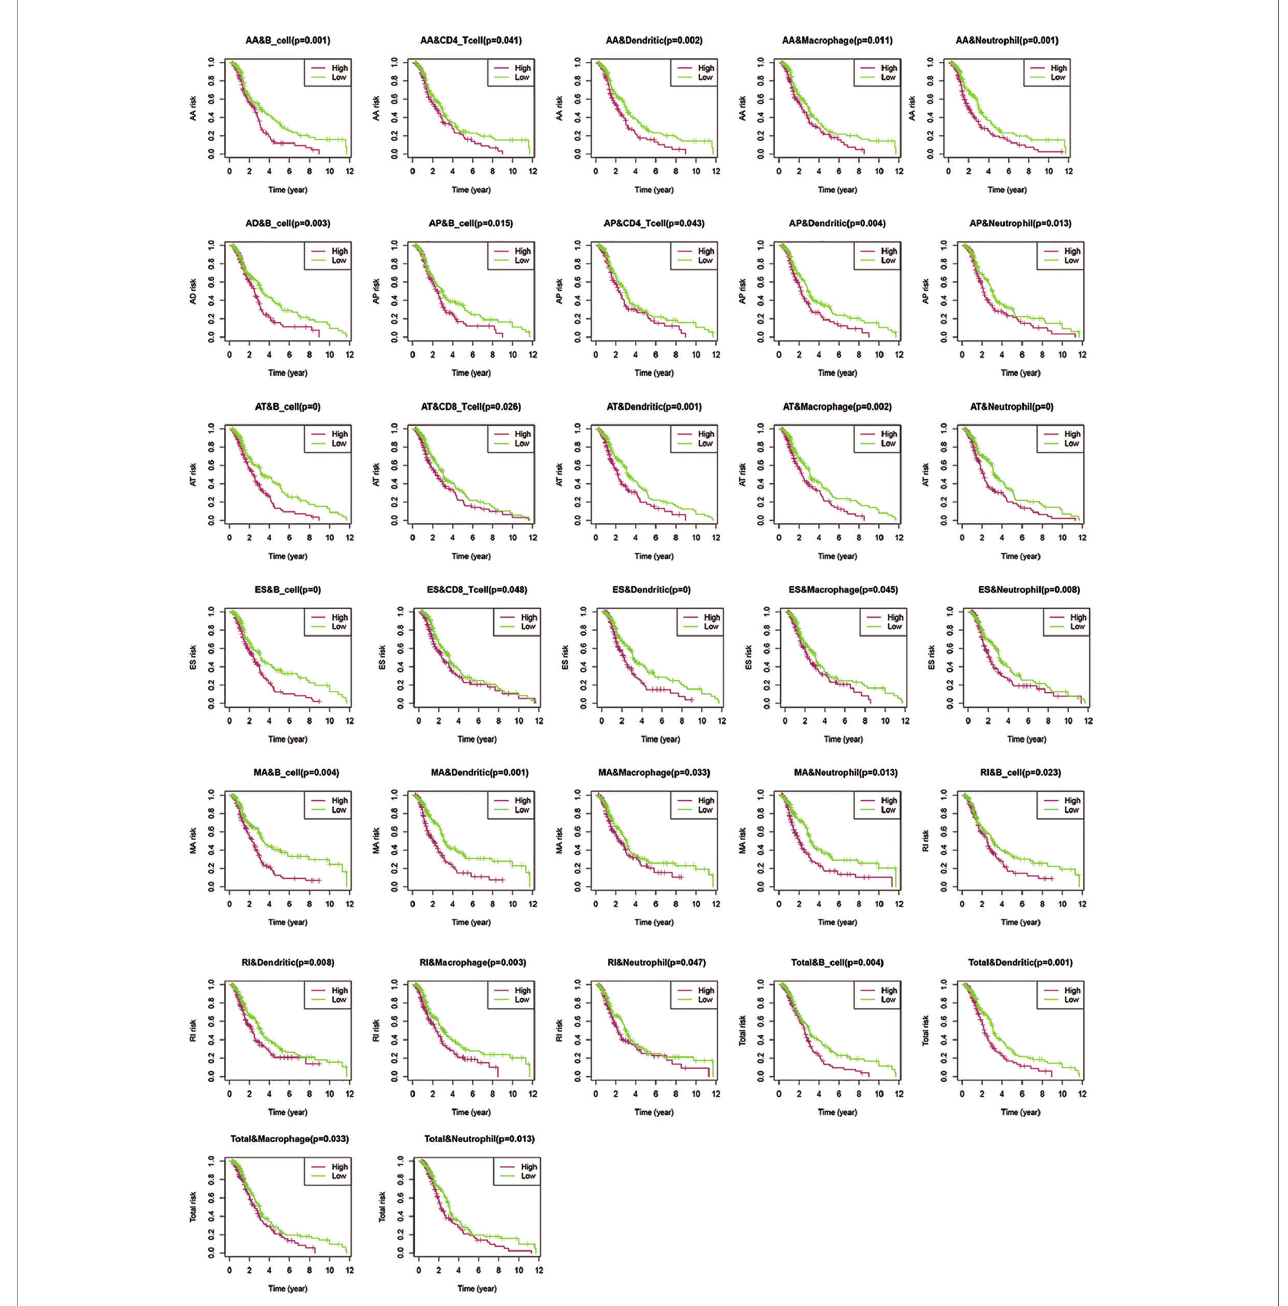
FIGURE 9 | Assessment of AS risk in relation to six immune in fi ltration cell types in CRC. After determining the correlation between low- and high-risk of different AS events in each cell type, samples with a calculated P -value < 0.05 were